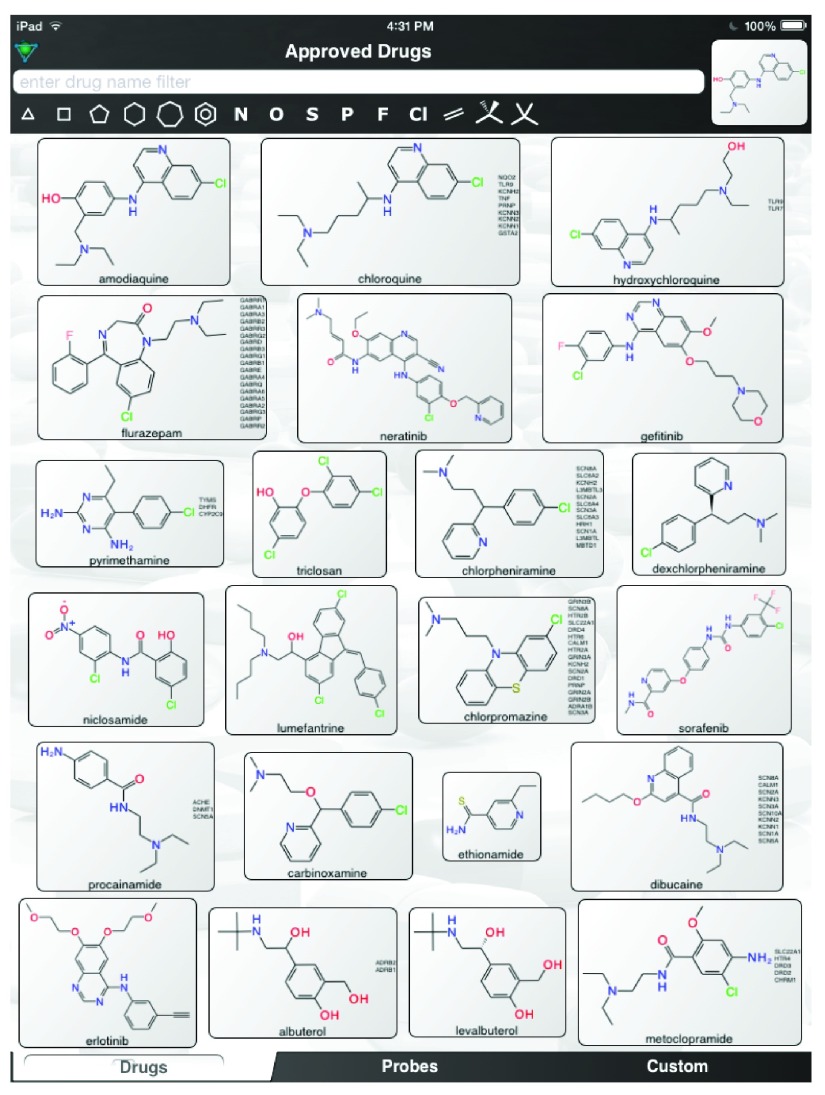
Amodiaquine similarity in Approved drugs mobile app
http://molmatinf.com/approveddrugs.html.